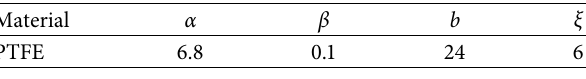
Table 8: Model parameters.